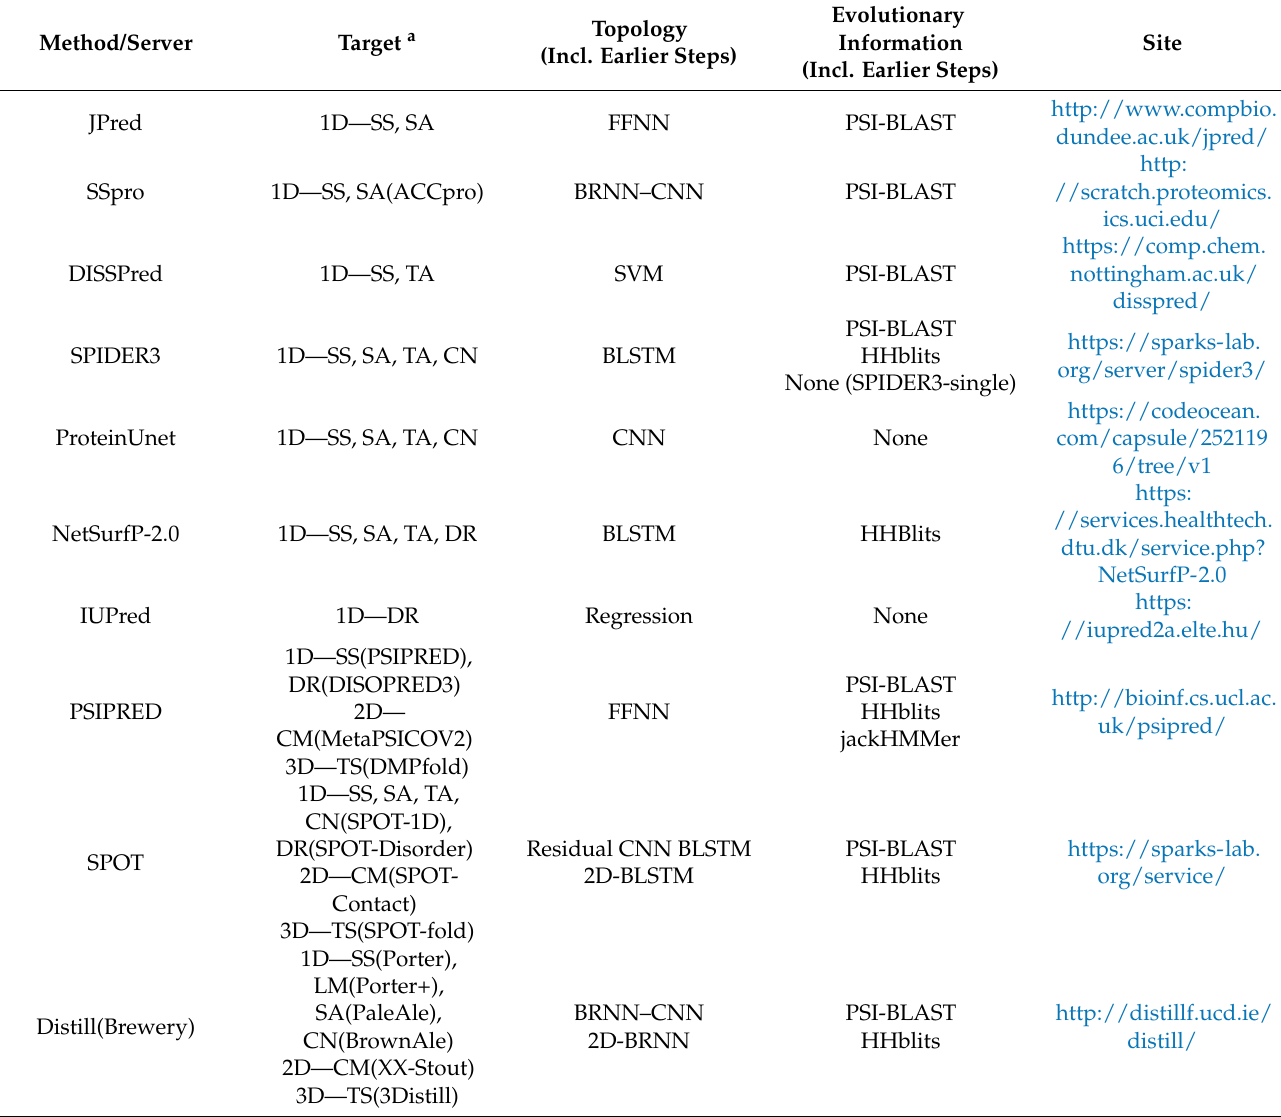
Table 1. List of methods for protein structure predictions. The entries consist of the most recent versions of the series. Method/Server Target a